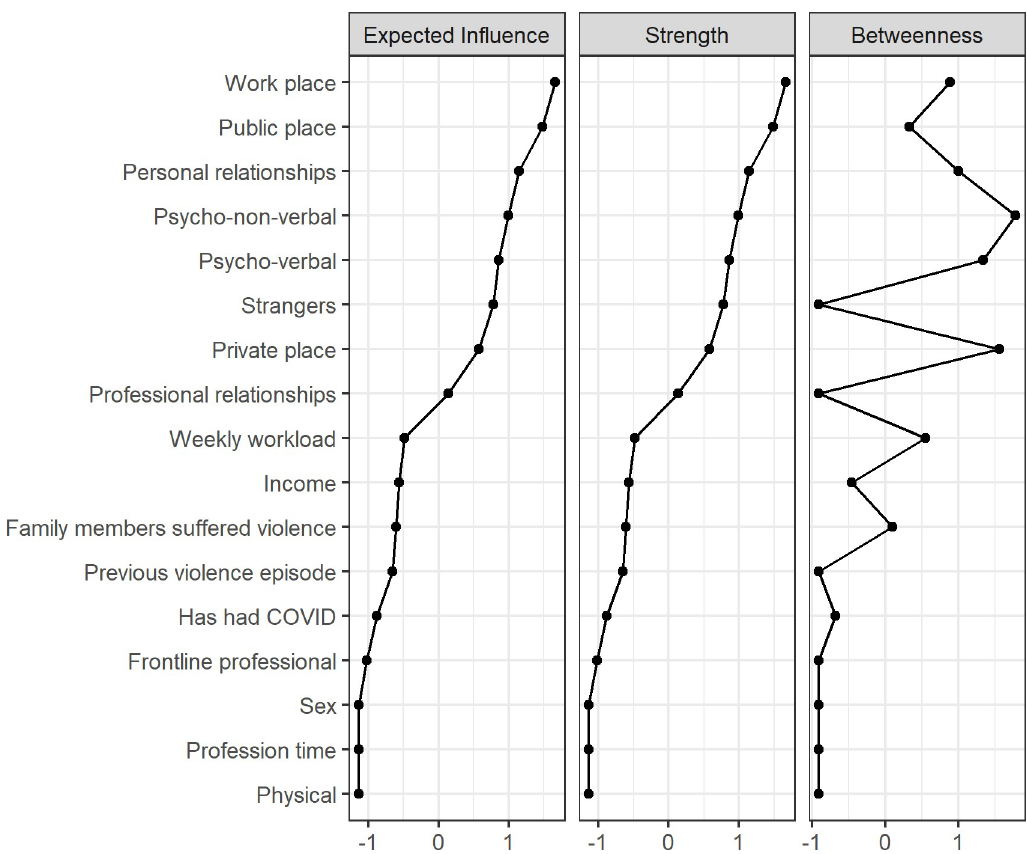
Fig 3. Centrality measures of sociodemographic variables related to the aggression suffered by healthcare